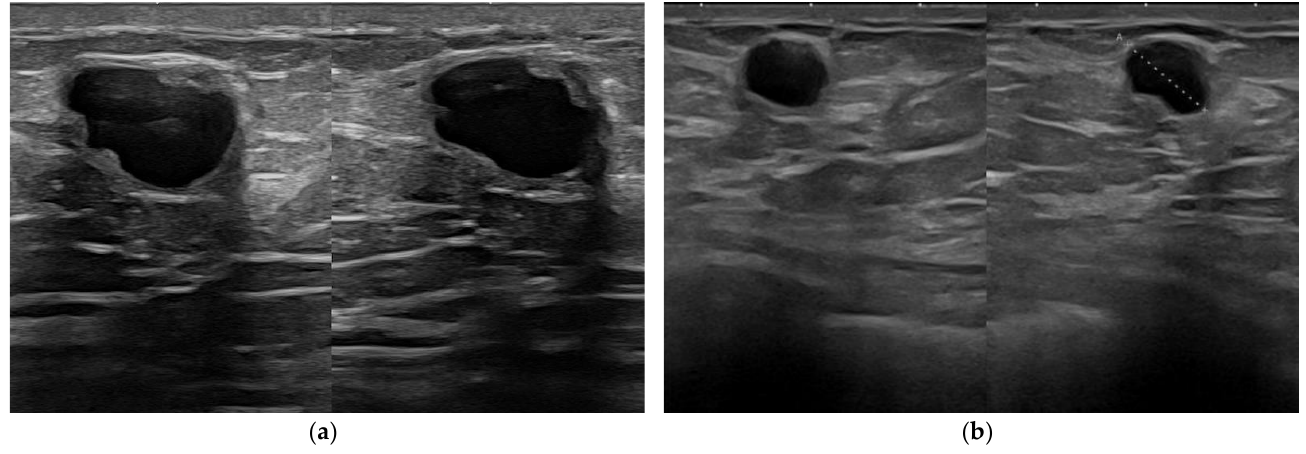
Figure 8. Complex fluid lesion due to post-surgical steatonecrosis. Given the superficial location of the abnormality, it is better depicted in its echotexture when imaged at 22 MHz ( a ) than at 15 MHz ( b ).